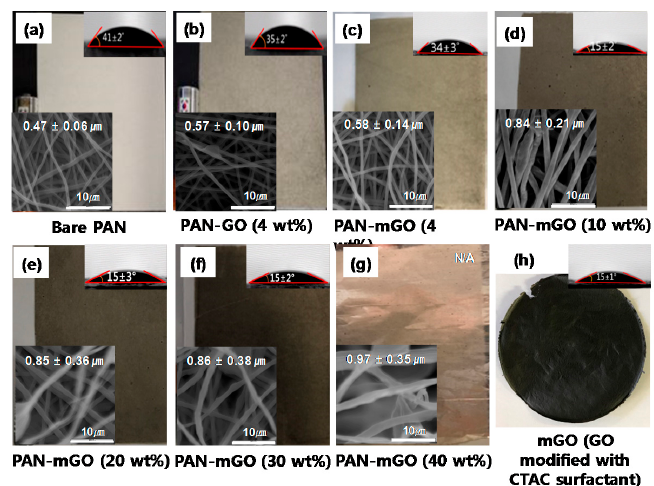
Figure 1. Bare polyacrylonitrile (PAN), surface-modified graphene oxide (GO), and series of PAN-GO composite membranes as a function of GO content.